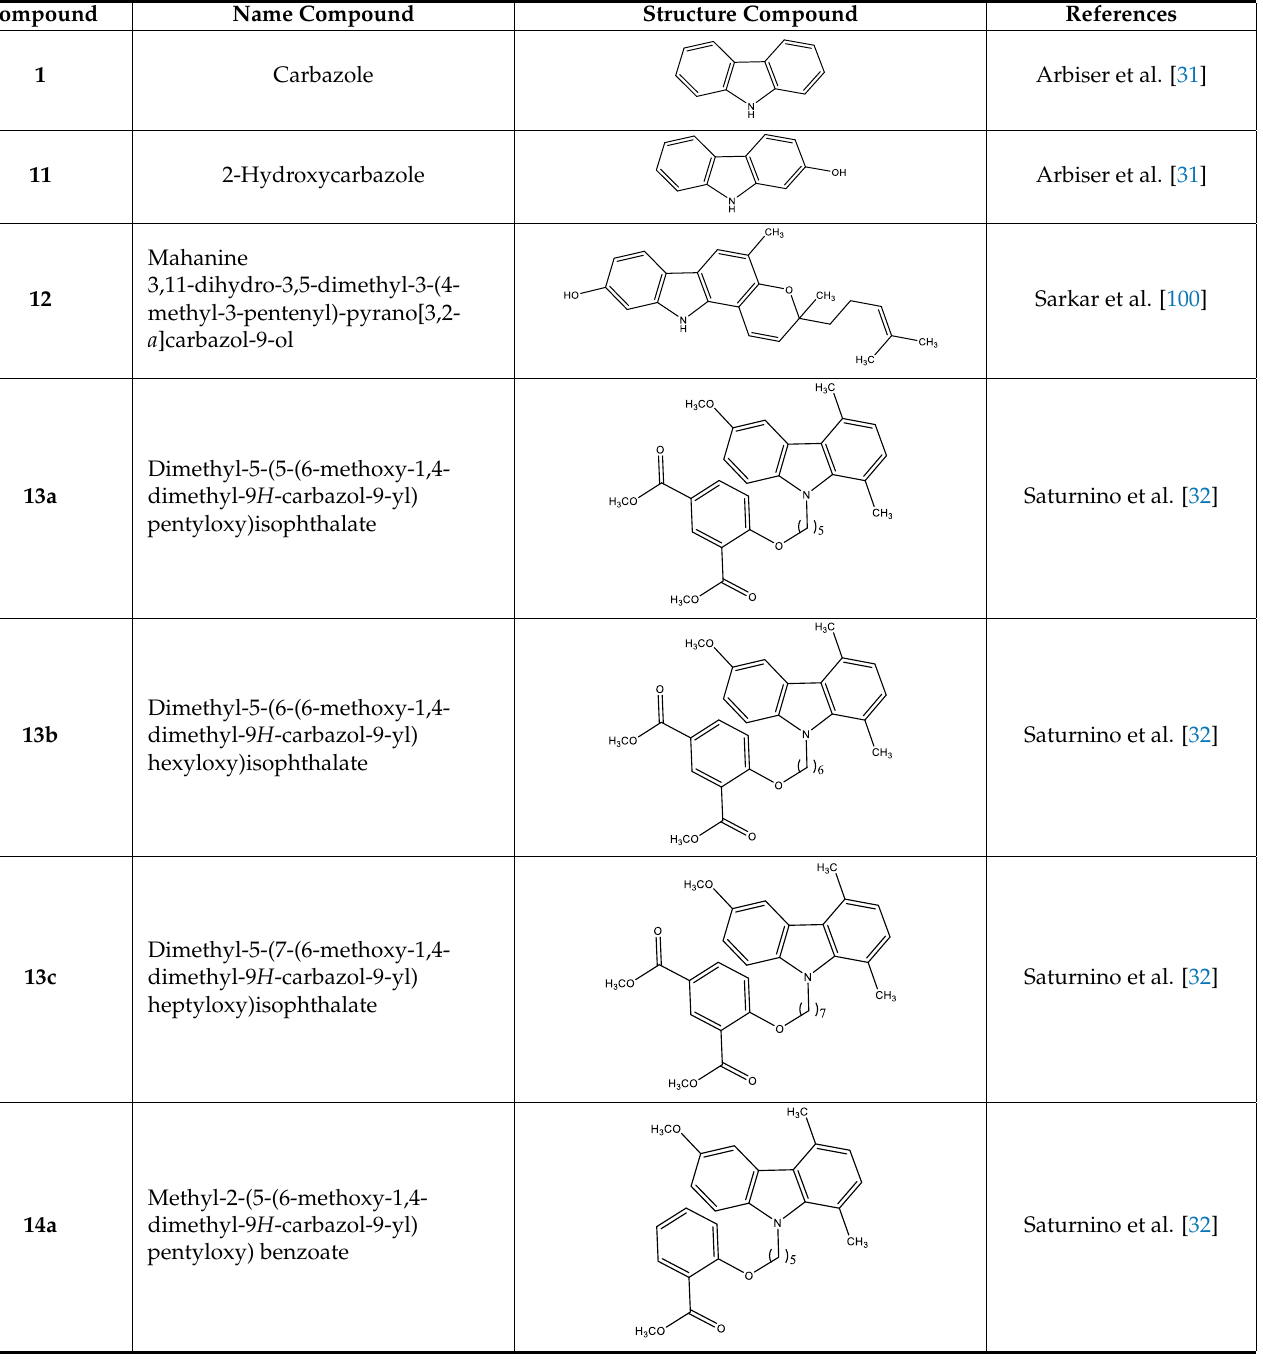
Table 1. Carbazole derivatives as stat Table 1. Carbazole derivatives as stat inhibitors. Table 1. Carbazole derivatives as stat inhibitors. Table 1. Carbazole derivatives as stat inhibitors. Table 1. Carbazole derivatives as stat inhibitors. Table 1. Carbazole derivatives as stat inhibitors. Table 1. Carbazole derivatives as stat inhibitors.